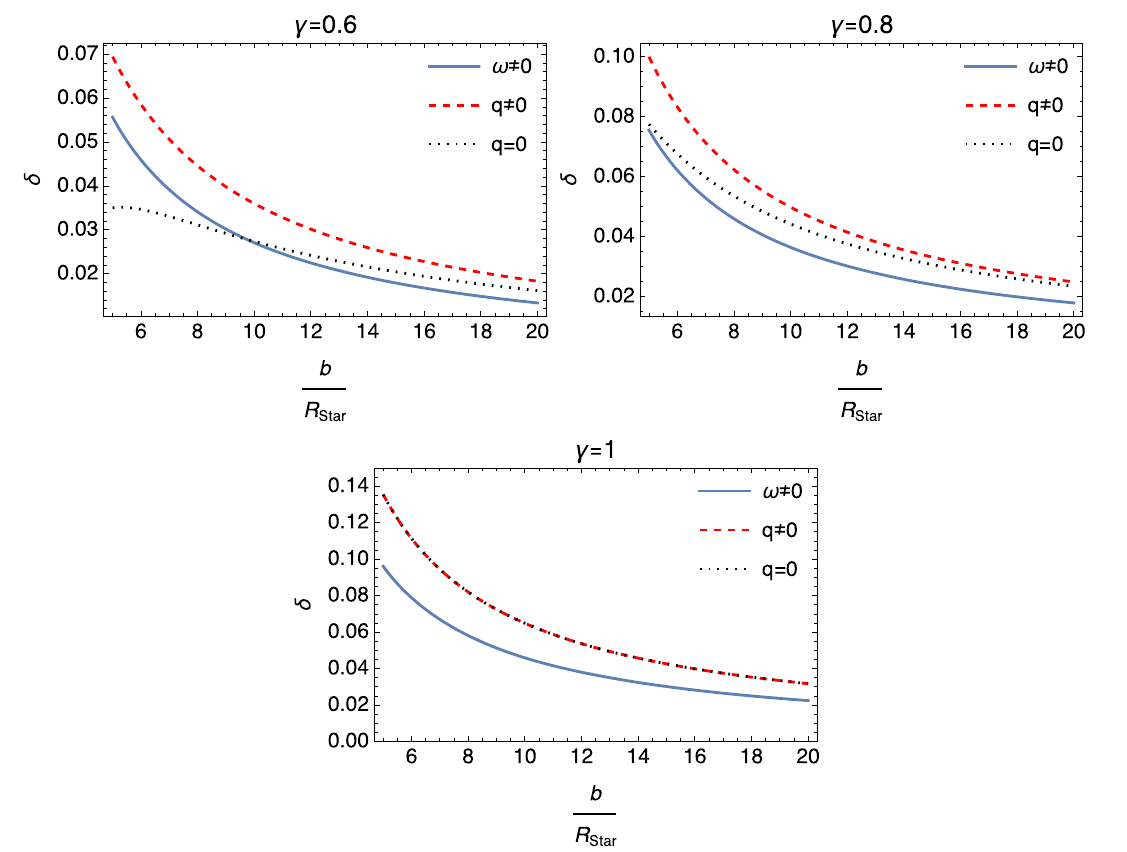
Fig. 10 Variation in the bending angle δ versus x is plotted for the compact object HerX-1. The star is considered for the cases of uncharged stationary (ω (cid:8)= 0 ) , static charged ( q (cid:8)= 0 ) and static uncharged ( q = 0 ) . Variation for each case are shown on the same graph for different values of deformation parameter